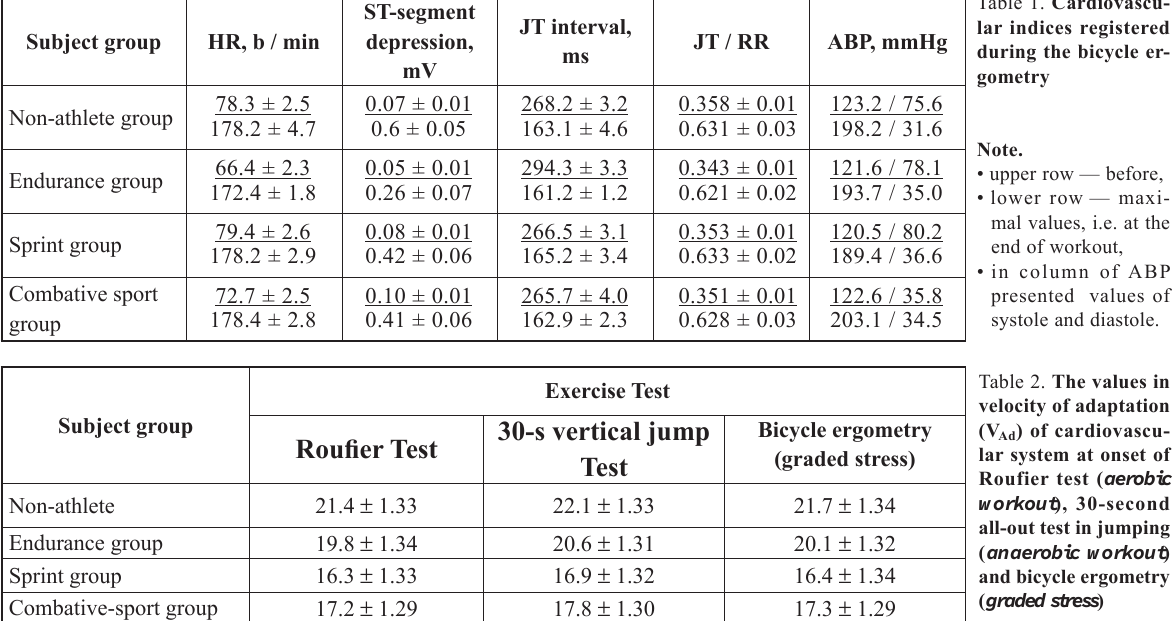
Note. • upper row — before,